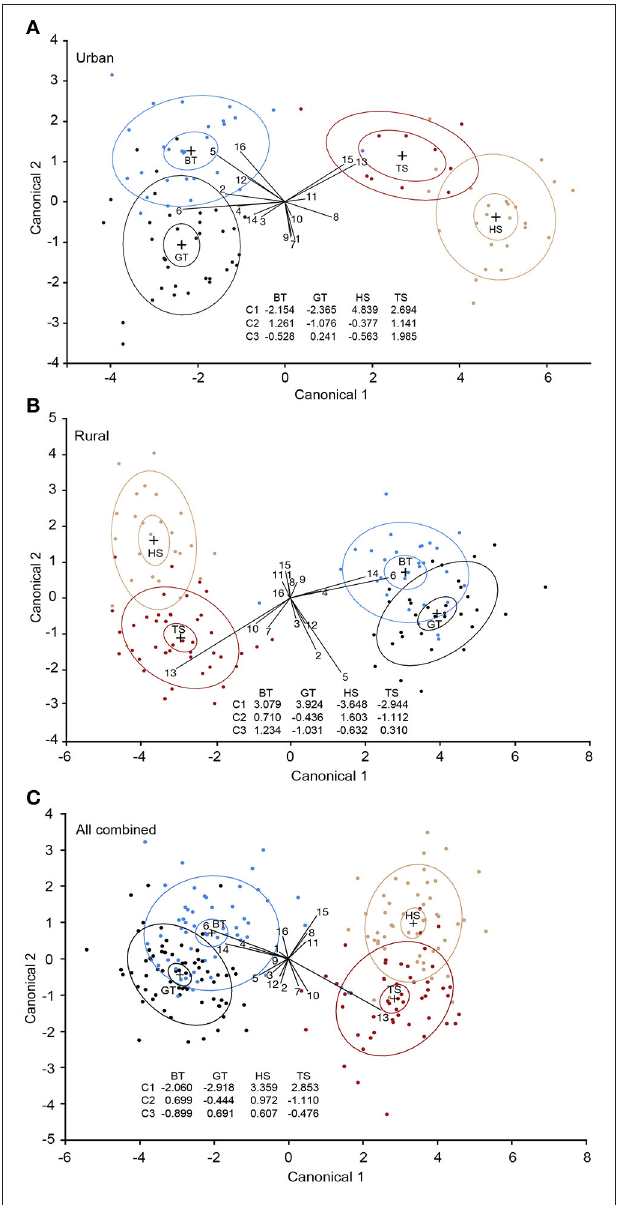
FIGURE 3 | Interspecific comparison of overall plasma fatty acid compositions in four passerine species. (A) Urban birds, (B) rural birds, and (C) urban and rural birds combined. The plots are based on the first (C1) and the second (C2) discriminant functions estimated from canonical discriminant analyses (CDA) using 15 individual fatty acids (FAs) along with total saturated fatty acids. Although the figure is two-dimensional, the CDA model is based on FA loadings of three functions, hence all three discriminant functions are presented. The ellipses represent 95% of the data clouds of each species. BT, blue tit (blue); GT, great tit (black); HS, house sparrow (tan); TS, tree sparrow (dark red). 1, palmitoleic acid; 2, oleic acid; 3, cis -vaccenic acid; 4, eicosenoic acid; 5, linoleic acid; 6, arachidonic acid; 7, γ -linolenic acid; 8, eicosadienoic acid; 9, dihomo- γ - linolenic acid; 10, adrenic acid; 11, α -linolenic acid; 12, eicosapentaenoic acid; 13, docosahexaenoic acid; 14, docosapentaenoic acid; 15, mead acid; 16, total saturated fatty acids.